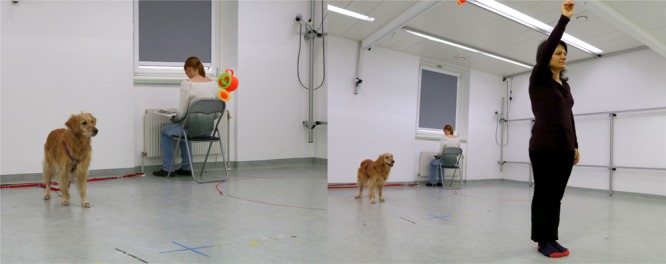
Dog watching the non-social stimulus (flying toy) and the social stimulus (moving human).